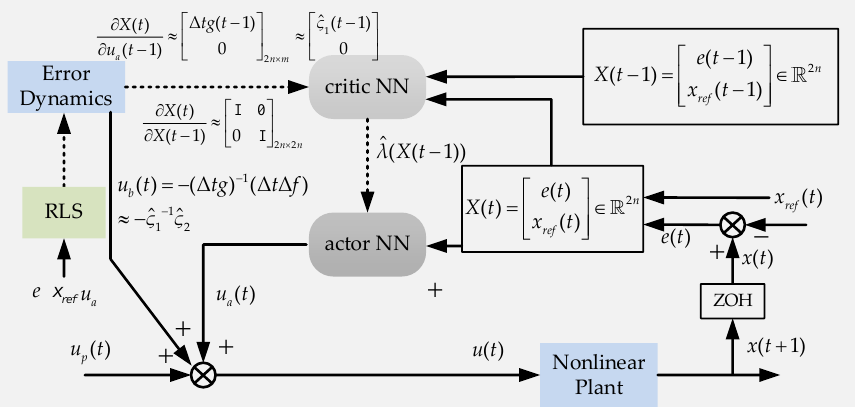
Figure 2. Schematic of ED-DHP.